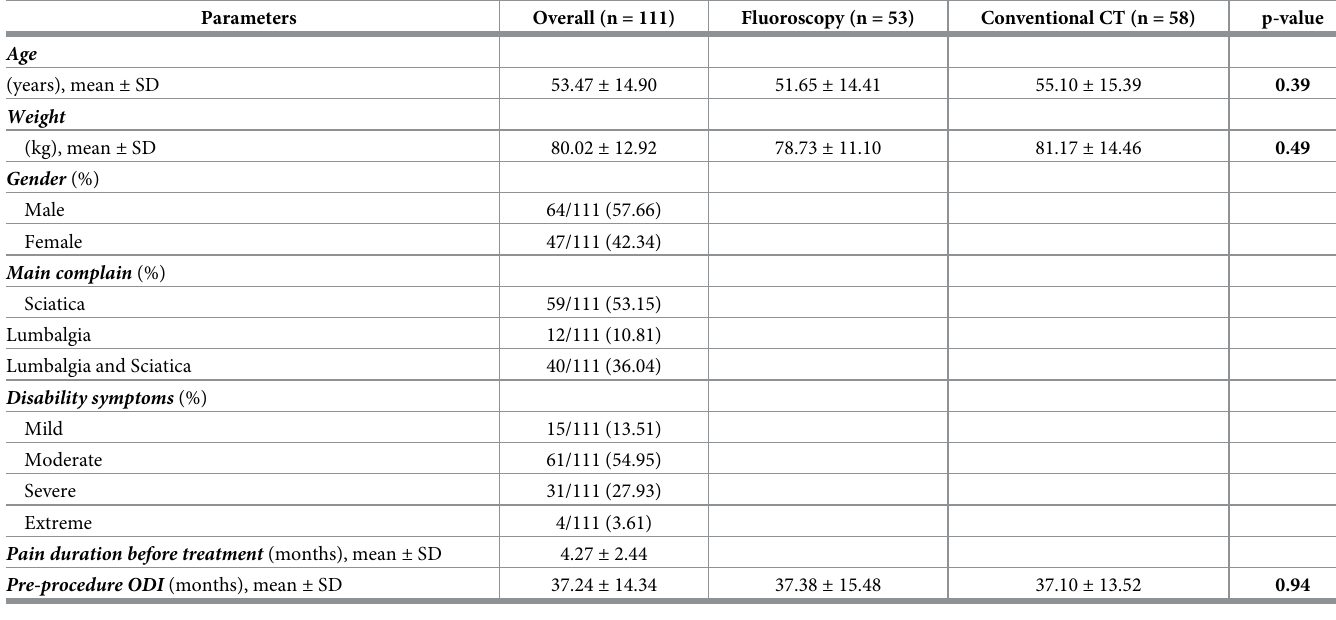
Table 1. Demographics of the patient population.